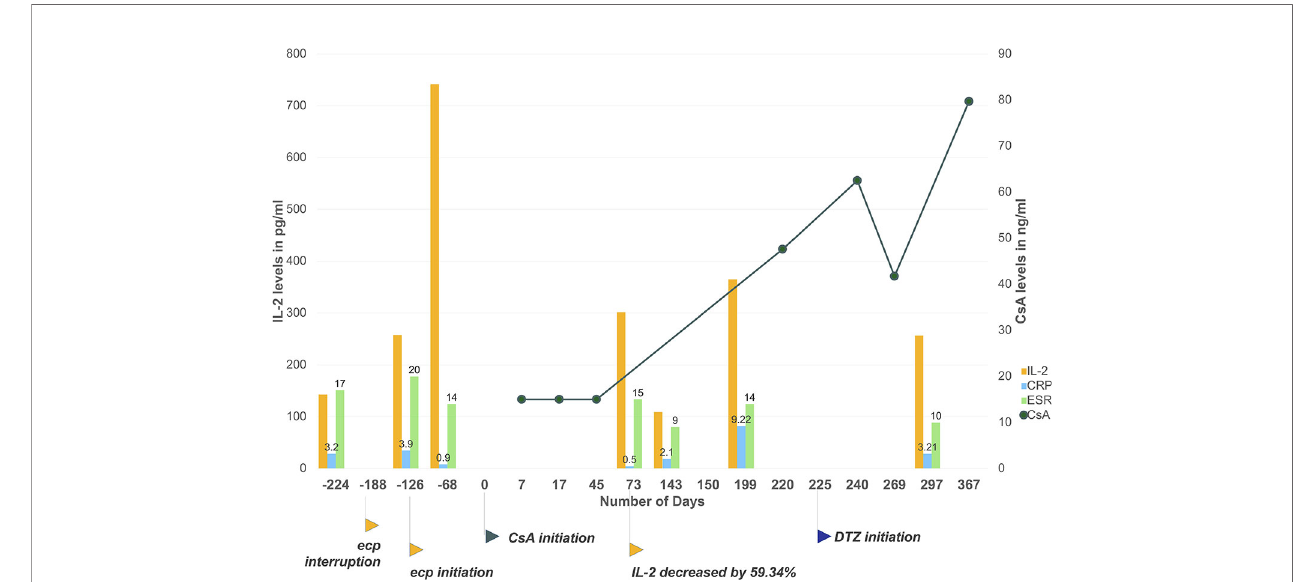
FIGURE 2 | Patient's CsA level, IL-2, and ESR/CRP levels monitoring during the time. Etanercept interruption has led to cytokine level fl uctuations and clinically unexpected CsA trough levels. The initiation of etanercept has induced a steep decline of IL-2, ESR and CRP levels due to in fl ammation resolution. Initiation of CsA overlapped with the decline. As a result, the fi rst three CsA level results were lower than the measurement range of applied immunoassay. From day 225 to day 367, CsA trough levels slowly increased to 79.7 ng/ml with co-administration of diltiazem and under more stable cytokine levels. Day 0 set as the fi rst day of CsA administration. Plotted CsA level results were measured with chemiluminescent magnetic microparticle immunoassay by hospital laboratory. Results below measurement range were taken as 15 ng/ml (half of assay lower detection limit). Csa, cyclosporine; ecp, etanercept; ESR, erythrocyte sedimentation rate; CRP, Creactive protein. Applied unit for CRP is mg/ml, for ESR is